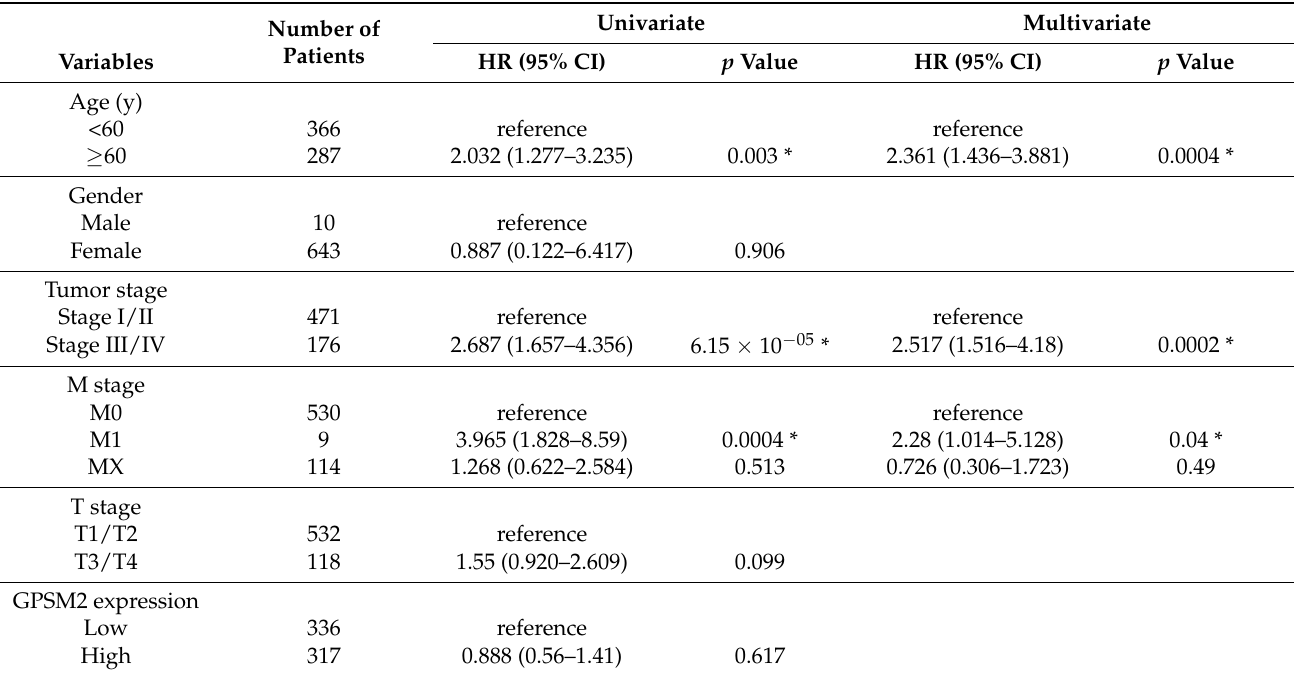
Table 2. Univariate and multivariate Cox proportional hazards regression analysis of factors affecting overall survival. Variables with significant association with overall survival in univariate analysis were then put into the multivariate analysis. HR, hazard ratio; CI, confidence interval; *: significant risk factor, p <